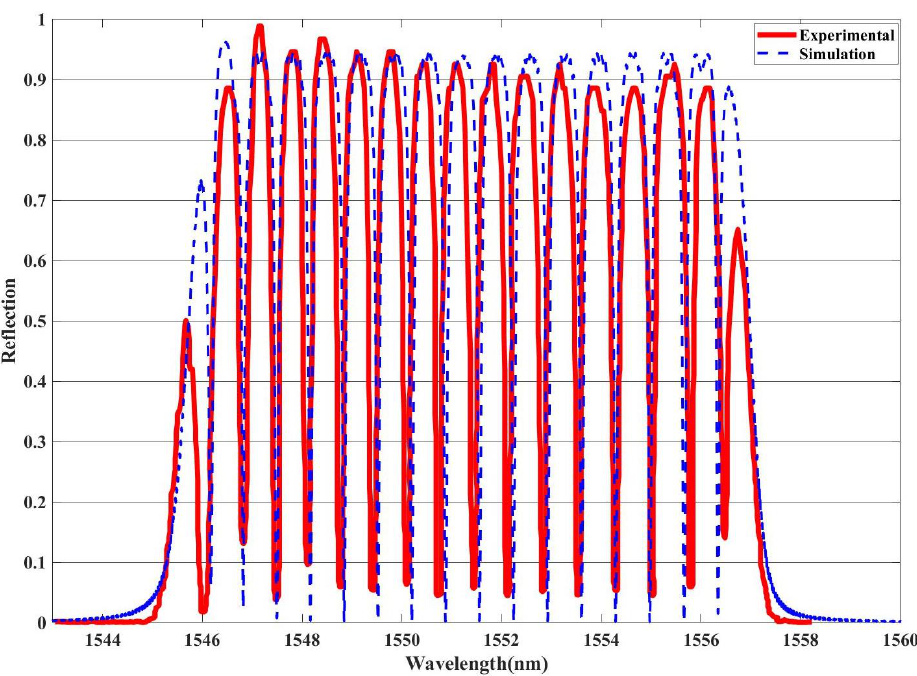
Figure 14. Comparison of the experimental (solid line) and simulated (dashed line) reflectance spectra for the 2D chirped fiber grating.